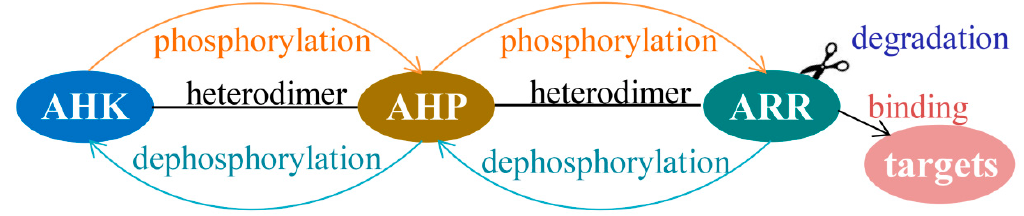
Figure 9. Model of TCS signaling specificity in Arabidopsis .